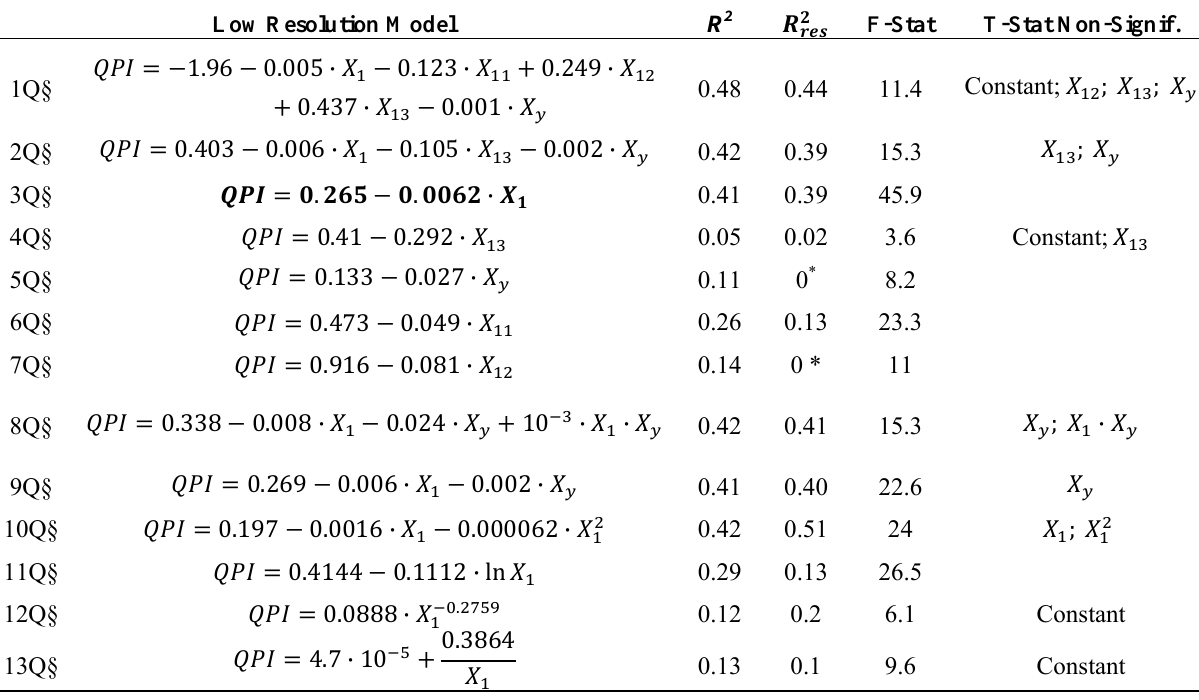
Table 11. Summary table for QPI prediction models adapted to low resolution maps. Low Resolution